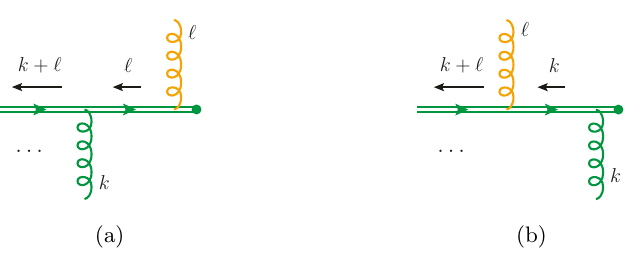
Figure 8 . The two possibilities of attaching a soft and a collinear gluon to an eikonal